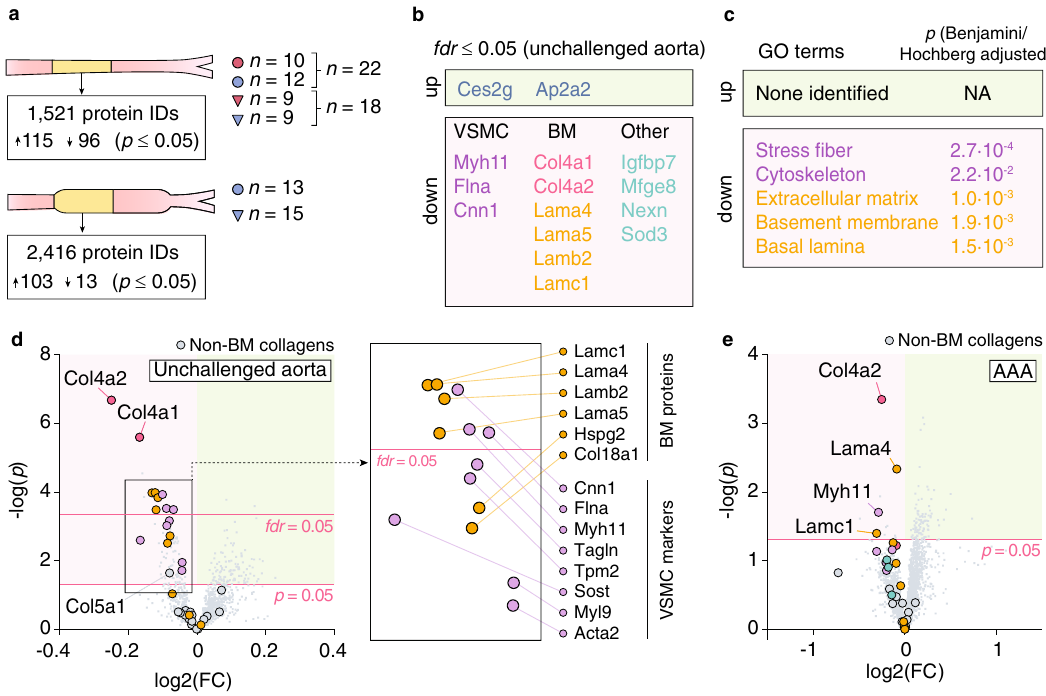
Figure 3. Col4a1/a2 is required to maintain VSMCs in the contractile phenotype. ( a ) Number of proteins identified in unchallenged aortas and proximal halves of AAA lesions, and the number of regulated proteins (uncorrected p ≤ 0.05) by the Col4a1/a2 + /− genotype for each condition. For unchallenged aortas, we analyzed 40 samples (aortas from 10 female Col4a1/a2 + / + mice, 12 female Col4a1/a2 + /− mice, 9 male Col4a1/a2 + / + mice, and 9 male Col4a1/a2 + /− mice) mixing sexes to increase statistical power. For AAA lesions, we analyzed 28 samples (AAA from 13 male Col4a1/a2 + / + mice and 15 male Col4a1/a2 + /− mice). ( b ) Significantly regulated proteins in unchallenged aortas after correction for multiple testing ( fdr ≤ 0.05). No proteins remained significantly regulated for AAA lesions after correction for multiple testing. ( c ) Significantly enriched GO terms among the 94 downregulated proteins (uncorrected p ≤ 0.05, excluding Col4a1/a2) in unchallenged Col4a1/a2 + /− aortas. No GO terms were significantly regulated for upregulated proteins (uncorrected p ≤ 0.05) in unchallenged aortas, or up- or down-regulated proteins (uncorrected p ≤ 0.05, excluding Col4a1/a2) in AAA lesions. ( d ) Volcano plot showing protein level changes in unchallenged Col4a1/a2 + /− aortas relative to Col4a1/a2 + / + aortas. Col4a1/ a2 (red), VSMC markers 29 (magenta), BM proteins (yellow), and non-BM collagens (grey) are magnified for clarity. Identities of regulated (uncorrected p ≤ 0.05) VSMC markers and BM proteins are shown in the parallel shifted rectangle. ( e ) Volcano plot showing protein level changes in Col4a1/a2 + /− AAA lesions relative to Col4a1/ a2 + / + lesions. The color code of magnified dots is the same as in ( d ). For ( d , e ), the red horizontal lines show the corrected ( fdr = 0.05) and uncorrected ( p = 0.05) level of significance, respectively. Data in ( b ) and ( d , e ) were analyzed by unpaired t-test for each protein followed by fdr correction for multiple